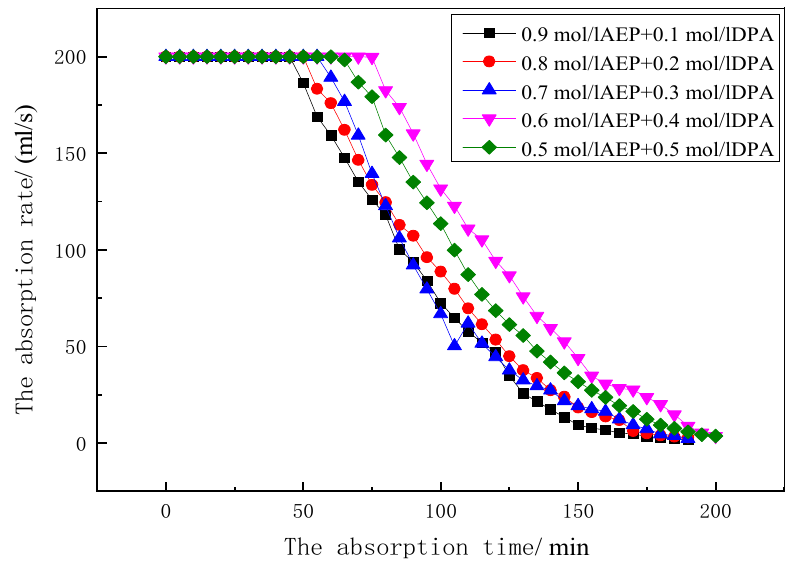
Figure 4. Absorption rate and absorption time curve of AEP-DPA composite system. As shown in Figure 5, for the five complex system solutions, the comparison of the absorption load was 0.6 mol/lAEP − 0.4 mol/lDPA > 0.5 mol/lAEP − 0.5 mol/lDPA > 0.7 mol/lAEP − 0.3 mol/lDPA > 0.8 mol/lAEP − 0.2 mol/lDPA > 0.9 mol/lAEP − 0.1 mol/lDPA, where 0.6 mol/lAEP − 0.4 mol/lDPA had an absorption capacity of 1.0817 mol for CO 2 (1.5453 mol CO 2 /mol solution), followed by 0.5 mol/lAEP − 0.5 mol/lDPA at 0.9867 mol (1.4096 mol CO 2 /mol solution).